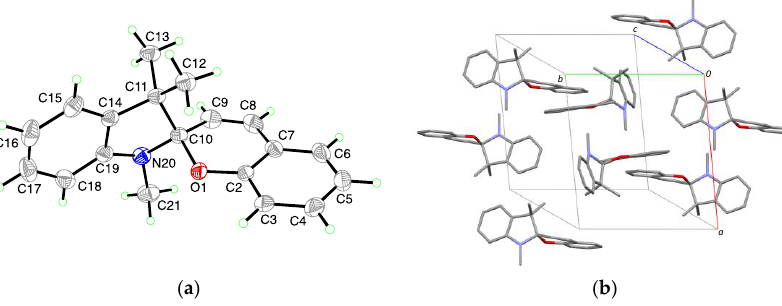
Figure 1. ( a ) A perspective view of (I), showing the atom-numbering scheme. Displacement ellipsoids are drawn at the 50% probability level. ( b ) A partial packing diagram for (I).